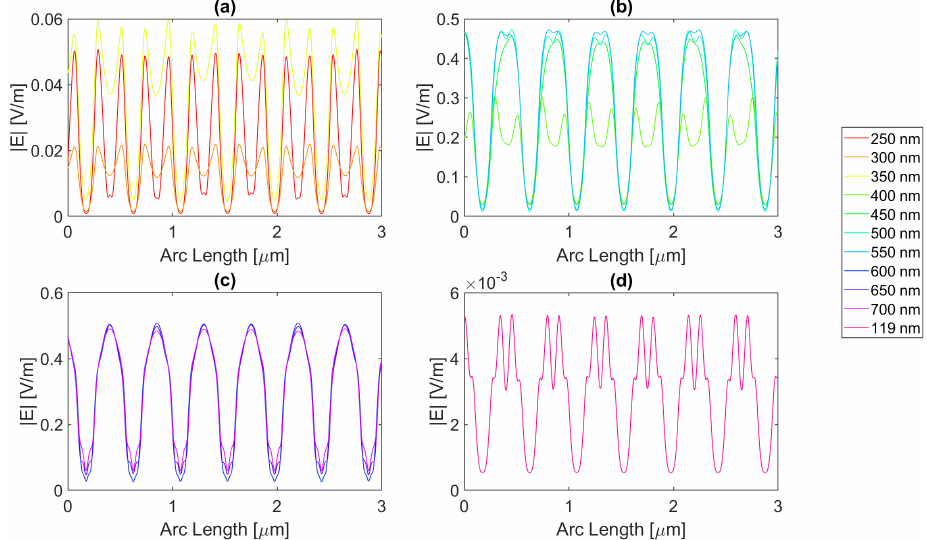
Figure 21. Electric field for the aluminium triangular nanostructure with a 100 nm base—Probe 1. Gold and copper, with electric field intensity curves as seen in Figures 22 and 23, present similar maximum values with 4.58 × 10 − 1 and 4.66 × 10 − 1 V/m electric field inten- sities and, 1.11 × 10 − 6 and 1.09 × 10 − 6 field integrals, respectively, at a 700 nm wavelength.